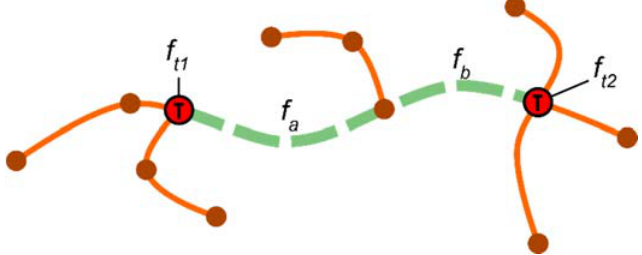
Figure 3. Schematic illustration of the road links in a multiplex HCT corridor. The green line symbolizes a potential HCT corridor between two terminal nodes. Orange lines are other links (roads) in the network, orange circles are other nodes.